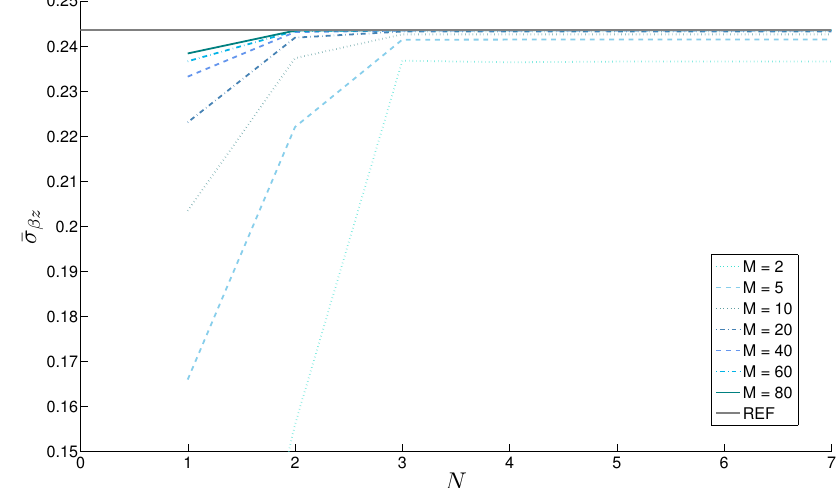
Figure 9. Case 1, one-layered FGM ( κ = 0.5) plate with thickness ratio a / h = 20. Stress ¯ σ β z ( a /2,0,0 ) vs. N order of expansion of the exponential matrix for different M numbers of global mathematical layers. Reference solution in Brischetto [23] is here indicated as REF.